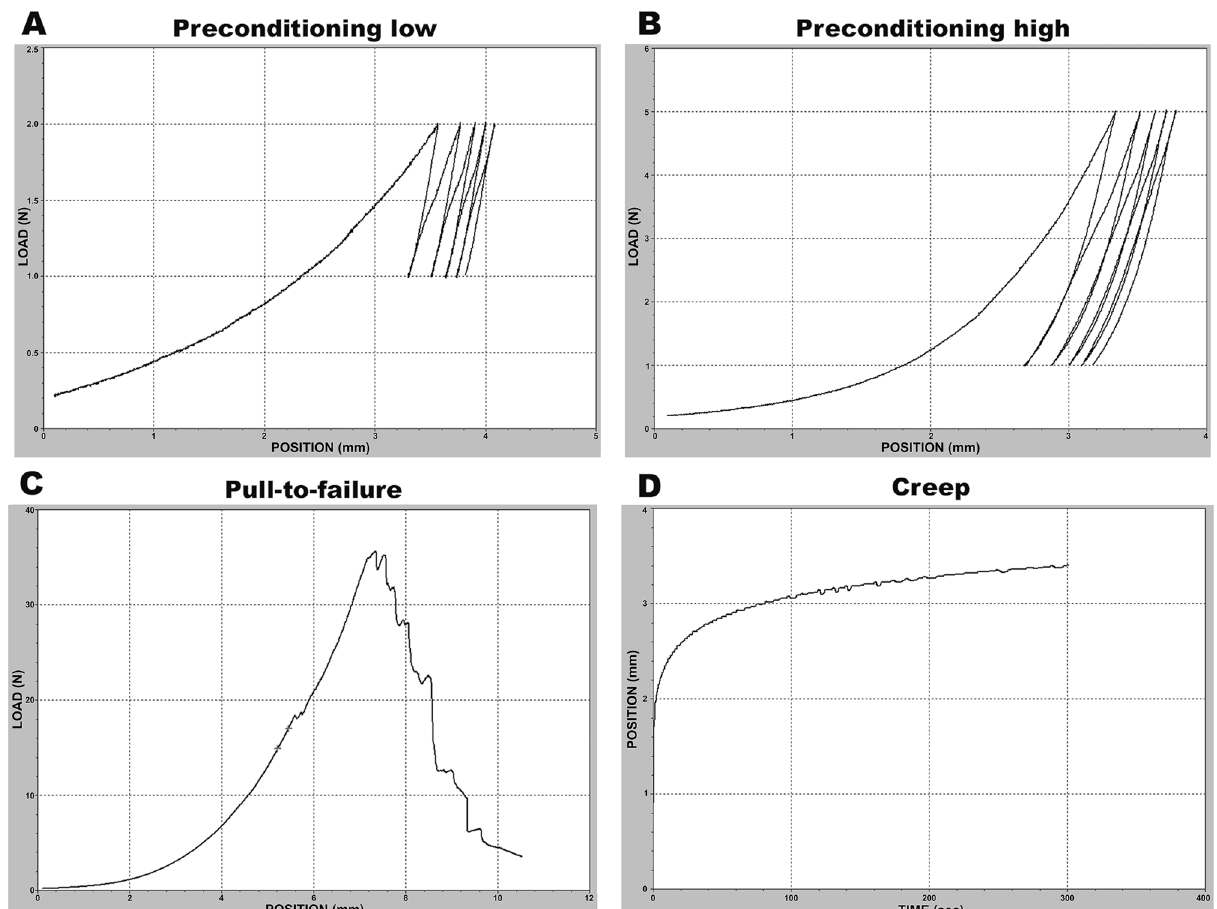
Figure 5. Representative overview of the type of mechanical test and preconditioning level performed in each experiment. Graphs are from a fresh sample. ( A , B ) represents the preconditioning graph, where 5 cycles of 2 N ( A ) or 5 N ( B ) were applied. ( C ) Pull-to-failure test. ( D ) Creep test with a constant load of 8 N for 300 s. Graphs were obtained from the mechanical testing (100R; DDL INC., EDEN PRAIRIE, MN) software MtestW, version5.1.0 (ADMET). https ://www.admet